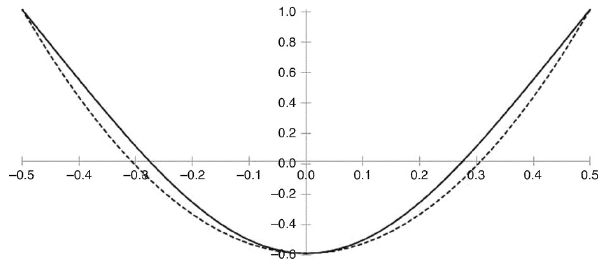
Fig. 1 The normalisation of the i mode shape and the reference degree of freedom